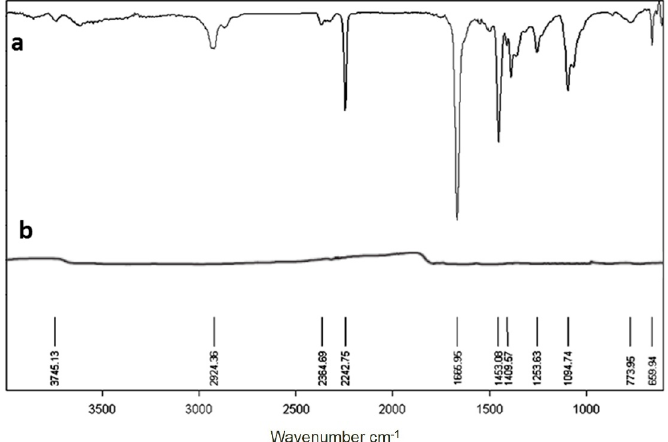
Figure 6. FTIR spectra of ( a ) the pure PAN; and ( b ) the calcined fiber at 1000 ˝ C under argon atmosphere.